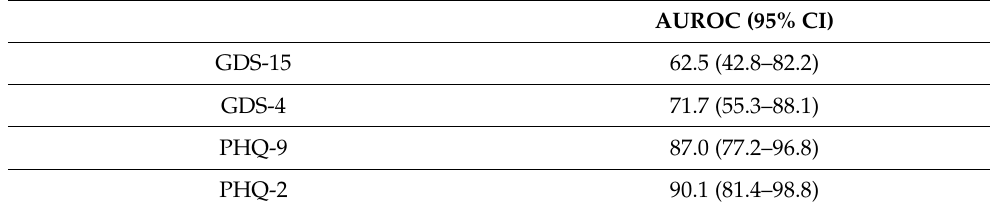
Table 2. Area under the ROC curve.